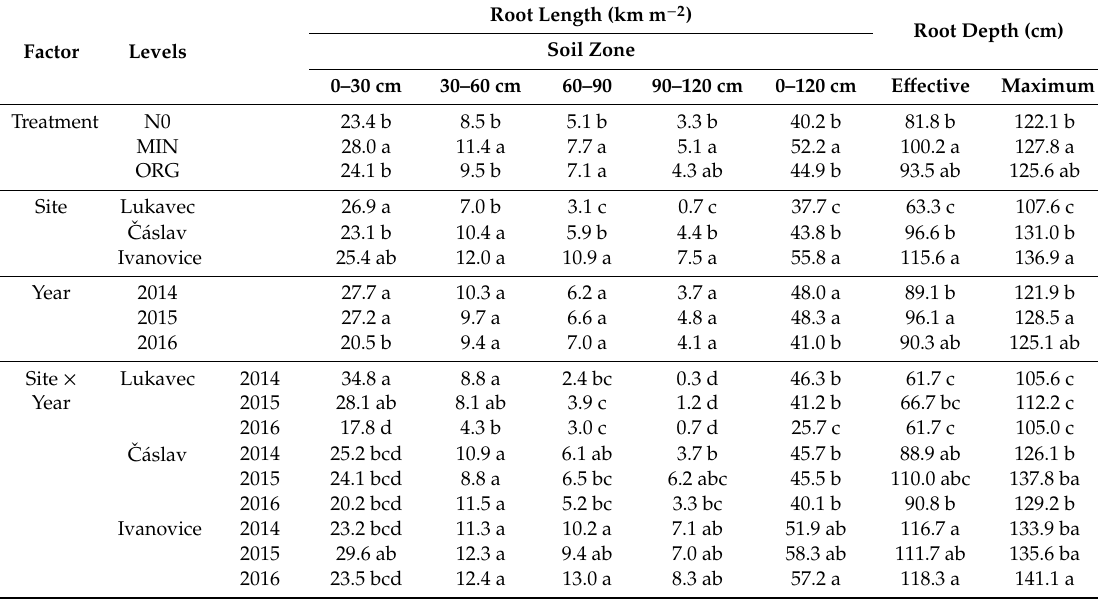
Table 3. Average wheat root lengths and depths for the three treatments, three sites, and three years, and the interaction of the site and the